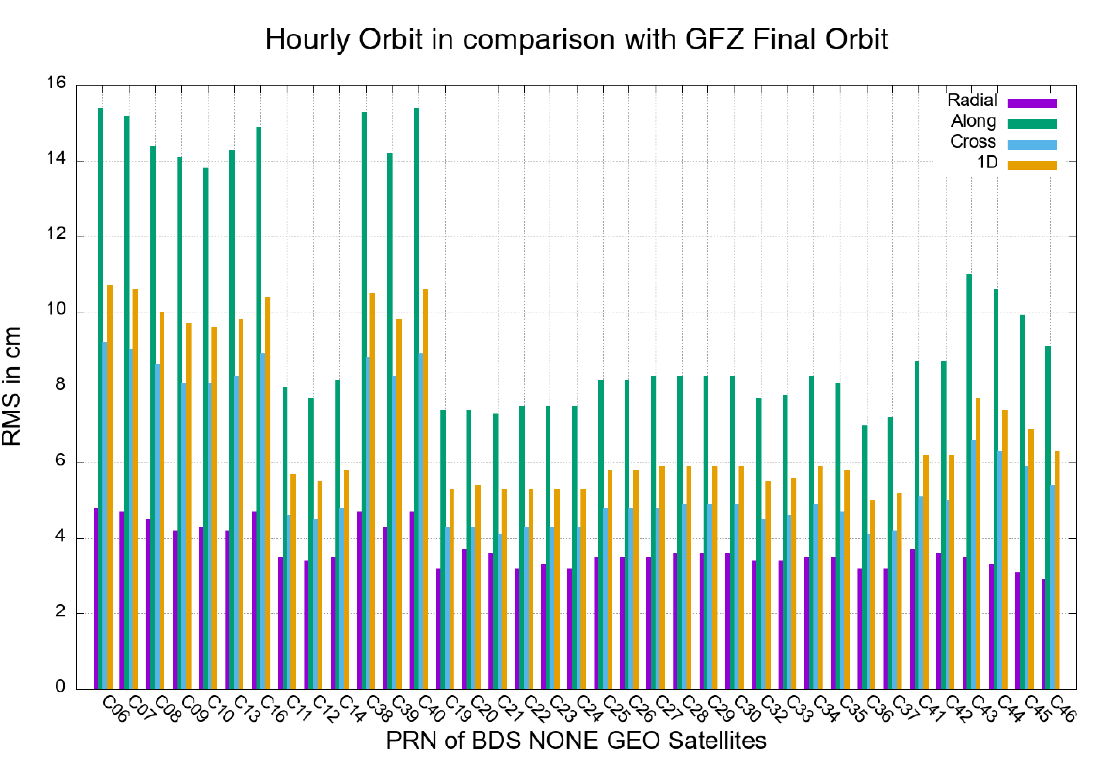
Figure 5. Mean RMS in the RAC components and 1-D of BDS NONE GEO satellites in comparison with GFZ final orbit.